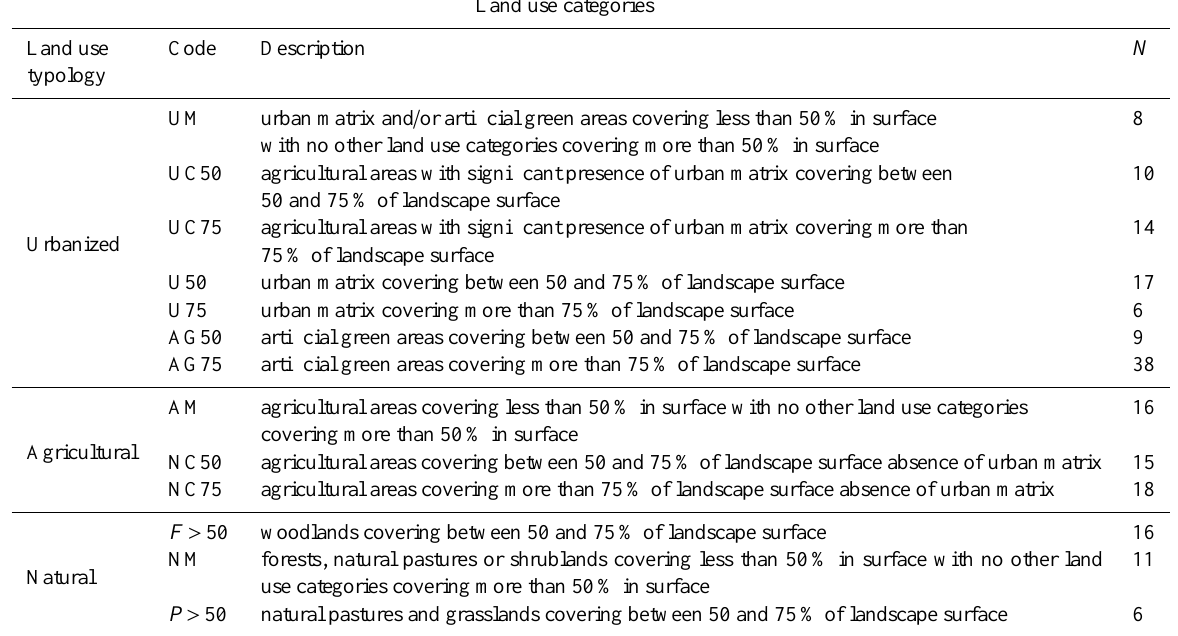
Table 1. Synoptic table summarizing the land use categories selected in the study area. To each land use category belonging to a main land use typology a code is assigned and a concise description is provided. The number of total point count station ( N ) falling into each land use category is also